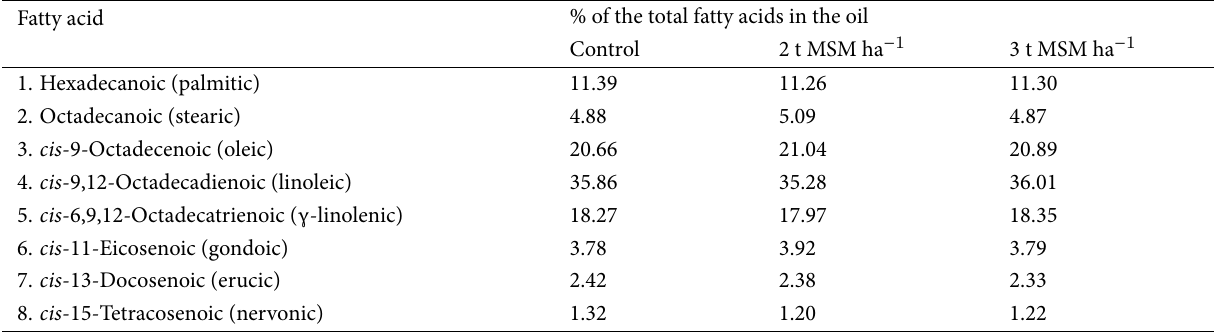
Table 5 Fatty acid composition of borage mericarp lipids. Fatty acid